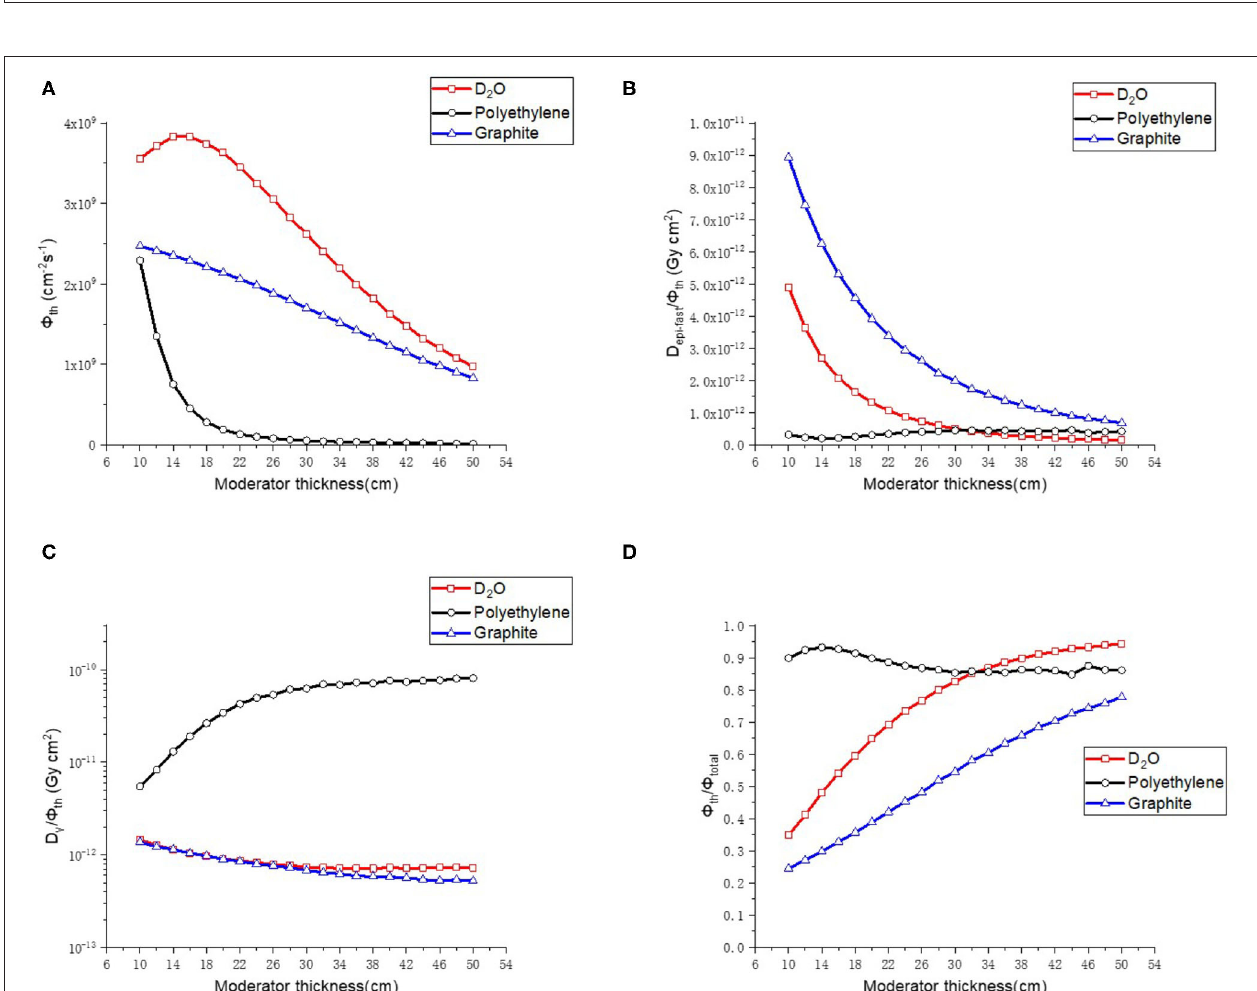
FIGURE 4 | Thermal neutron parameters of moderator, (A–D) are thermal neutron flux, thermal neutron ratio, epithermal, and fast neutron component, Gamma component, respectively.